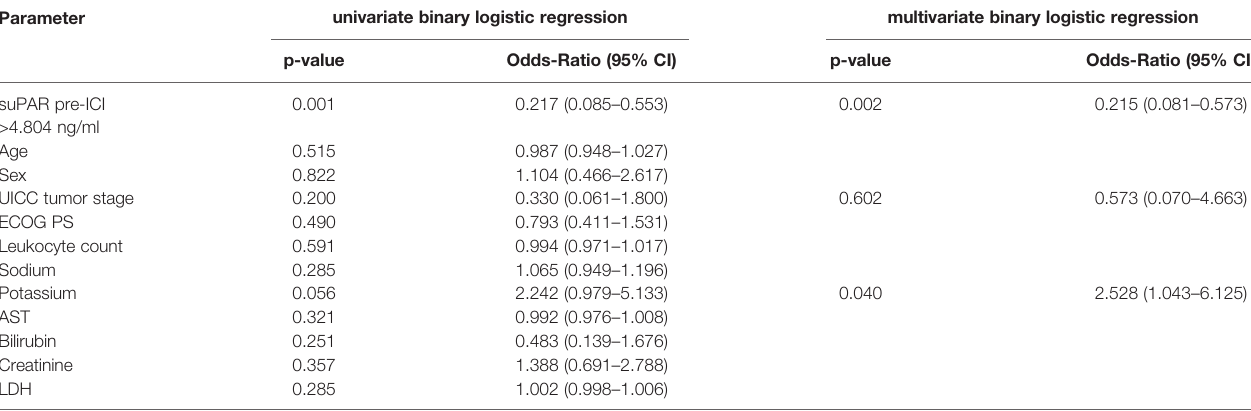
TABLE 2 | Uni- and multivariate binary logistic regression analysis for the prediction of tumor response to checkpoint inhibitors. univariate binary logistic